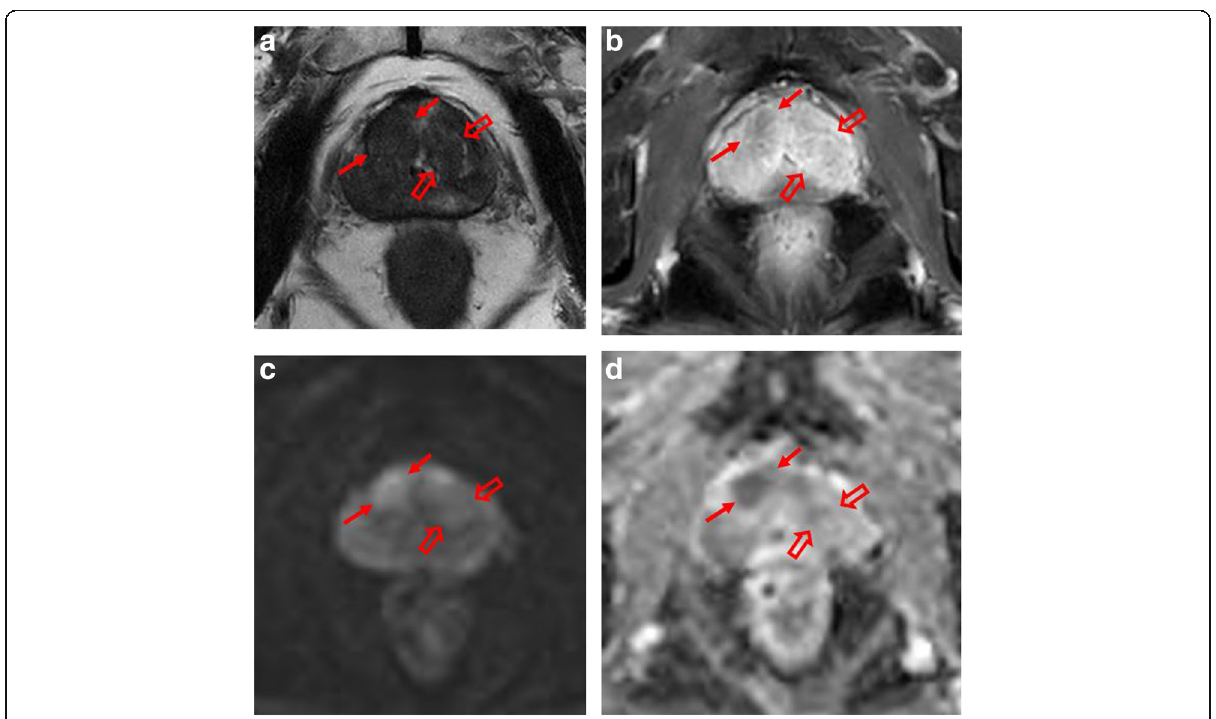
Fig. 6 Multiparametric magnetic resonance image of a 81-year-old patient with serum PSA 15.9 ng/ml. An axial T2-weighted image (T2WI) and dynamic contrast-enhanced image ( a , b ) indicate an approximately 1.3 cm, obscured marginated, heterogeneous nodule with minimal enhancement in the right transition zone (arrows), resulting in a T2WI score of 3. The other 9-mm-sized encapsulated, homogeneous nodule was detected in the left transition zone (opened arrows), revealing T2WI score of 2. Diffusion-weighted imaging (DWI) ( b = 1000) and ADC map ( c , d ) demonstrated focal marked diffusion restriction at the corresponding right transition zone nodule (arrows) with low signal intensity on an ADC map (DWI score 4, with ADC value of 0.620), and left transition zone nodule revealed no diffusion restriction (DWI score 1, with ADC value of 1.040). These lesions were each categorized as category 3B (right transition zone) and 2 (left transition zone), according to PI-RADS v2.1-B, and we recommended biopsy for right transition zone nodule. These lesions were confirmed right transition-zone cancer with a Gleason score of 7 (3 + 4), and benign hyperplastic nodule in left transition zone,